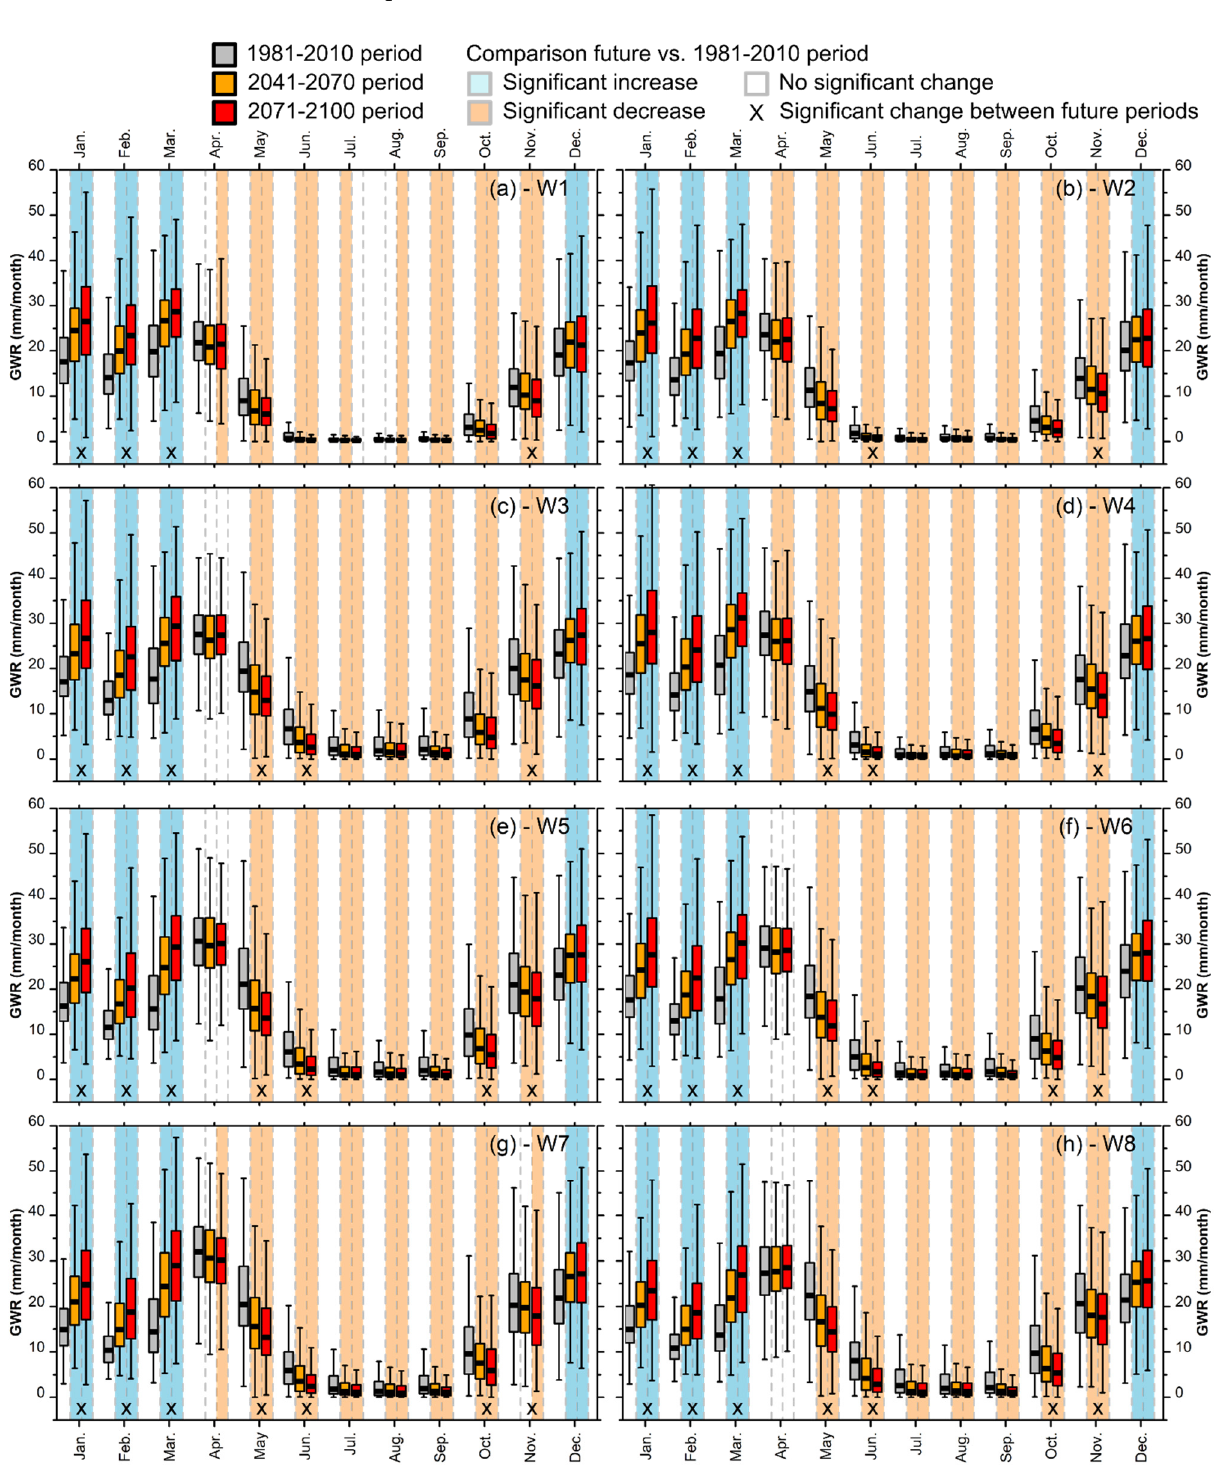
Figure 8. Monthly groundwater recharge (GWR) for the reference period (1981–2010) and the two future periods (2041–2070 and 2071–2100) for ( a ) W1 to ( h ) W8. The sum of GWR from December to March increased by +32 mm on average (mean of the ensemble of scenarios), from +27 mm in W1 to +36 mm in W7 and between